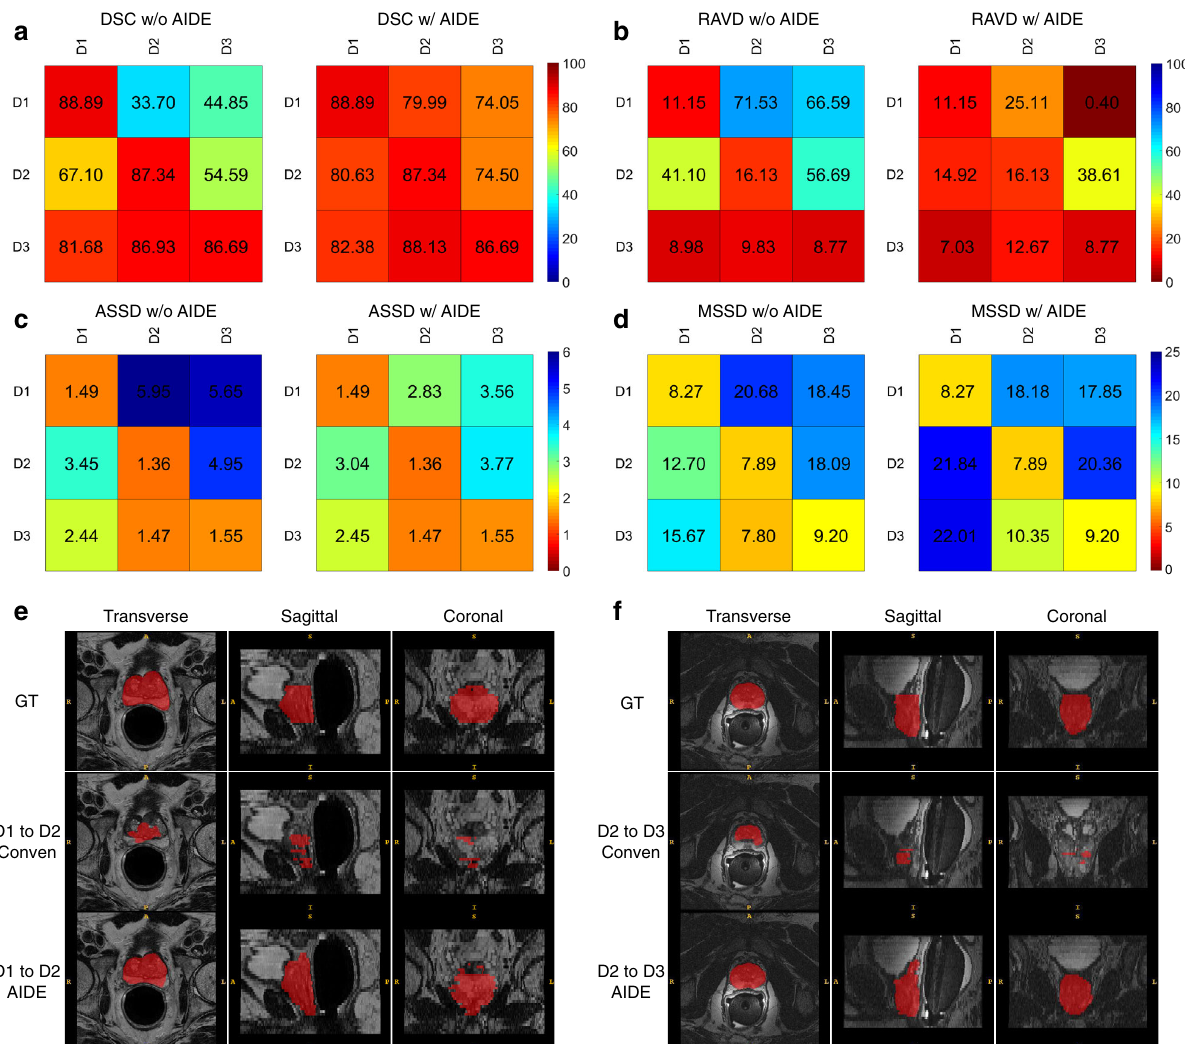
Fig. 3 Results of prostate segmentation for UDA. a – d , The four evaluation metrics, DSC (%), RAVD (%), ASSD (mm), and MSSD (mm). In each sub fi gure, the left and right mappings indicate that the networks are trained without and with the proposed AIDE. D1, D2, and D3 refer to domains 1, 2, and 3. In each mapping, the vertical axis indicates the dataset utilized to train the models and the horizontal axis indicates the dataset utilized to test the models. e – f Example segmentation results when transferring models between domains. GT stands for ground truth, referring to the high-quality annotations. Conven is conventional, indicating that the results are generated by a fully supervised optimization method utilizing the combined dataset (high-quality labels for the source domain training data and model-generated low-quality labels for the target domain training